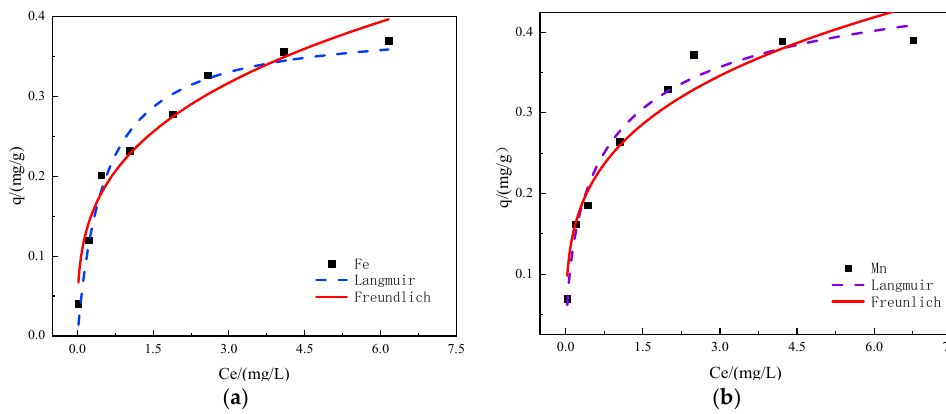
Figure 10. Adsorption isotherm models of iron ( a ) and manganese ( b ) ions. Table 7. Constants of Langmuir and Freundlich isotherms. Langmuir Freundlich